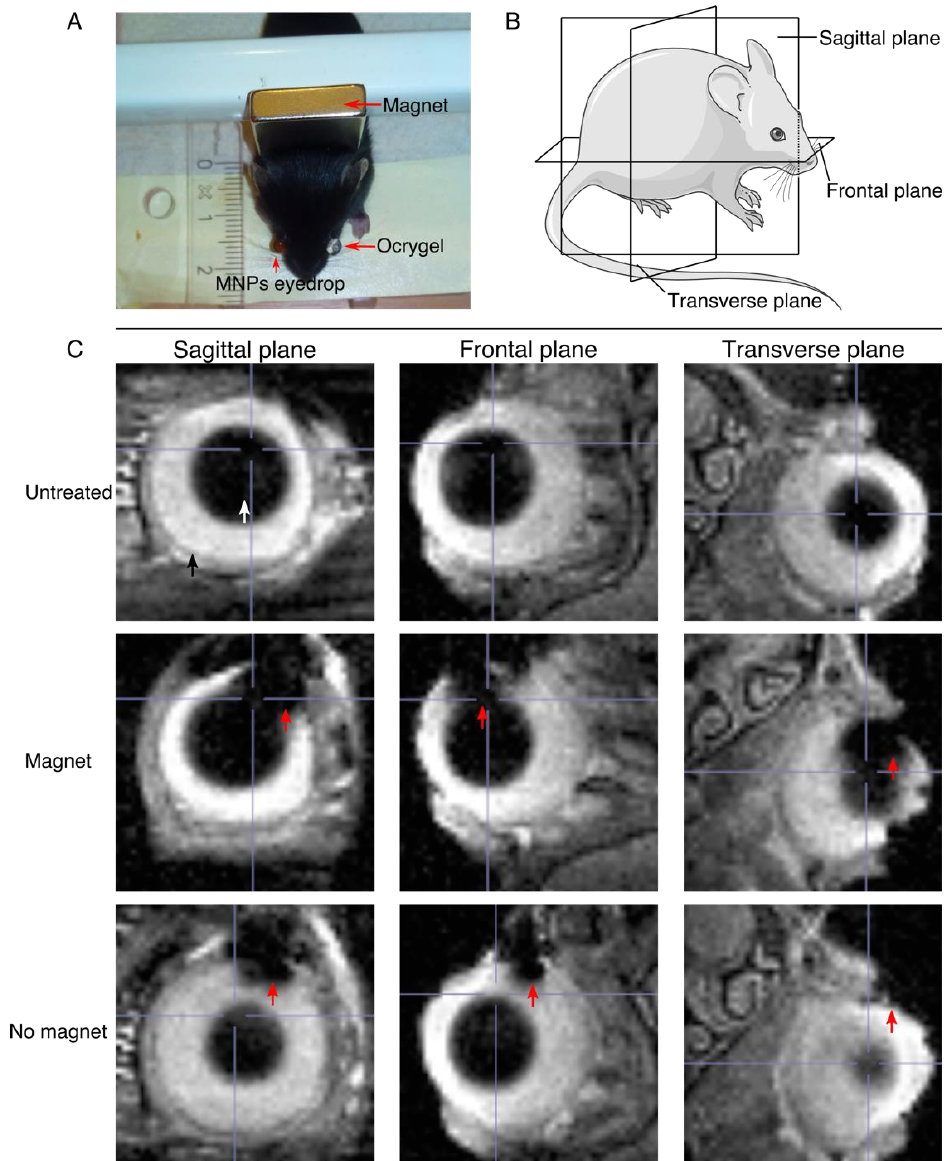
Figure 3. MRI image acquisition and MRI images showing the penetration of the MNPs into the ocular tissues. ( A ) Illustration of the experimental setup for the mouse experiment. ( B ) Illustration of the different planes used in the MRI image acquisition. ( C ) MRI images showing the penetration of the MNPs into the ocular tissues. The three different planes of acquisition are shown for the untreated mice and mice treated with and without the influence of the magnetic field. The red arrow points at the MNPs, the white arrow points at the lens, and the black arrow points at the eyeball. An MNP-based (NP01+NP04) eye drop mix was instilled on the right eye (treated eye), while the left eye (control) was covered with Ocrygel. The magnetic targeting was carried out for 45 min by placing a 0.4-Tesla magnet behind the mouse’s head, as shown